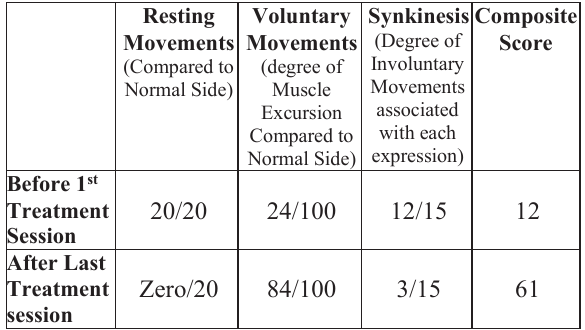
Table-2: Scores of Sunnybrook Facial Grading